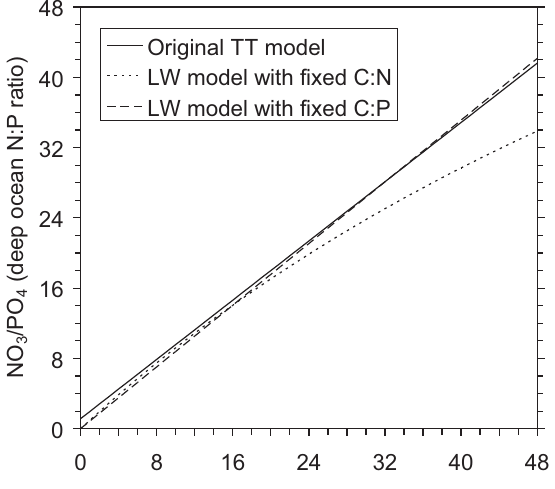
Fig. 5. Analytic solutions for the dependence of the steady state deep ocean N:P ratio on the N:P Redfield ratio of the phytoplankton, when assuming that it determines the N:P threshold that triggers N 2 -fixation ( r N : P = r N : P , Fix in the LW model). This assumption is implicit in the TT model for the default parameter settings. Results for the original TT model (solid line), and the LW model when as- suming either fixed C:N Redfield ratio ( r C : N =117/16=7.3125, dot- ted line) or fixed C:P Redfield ratio ( r C : P =117, dashed